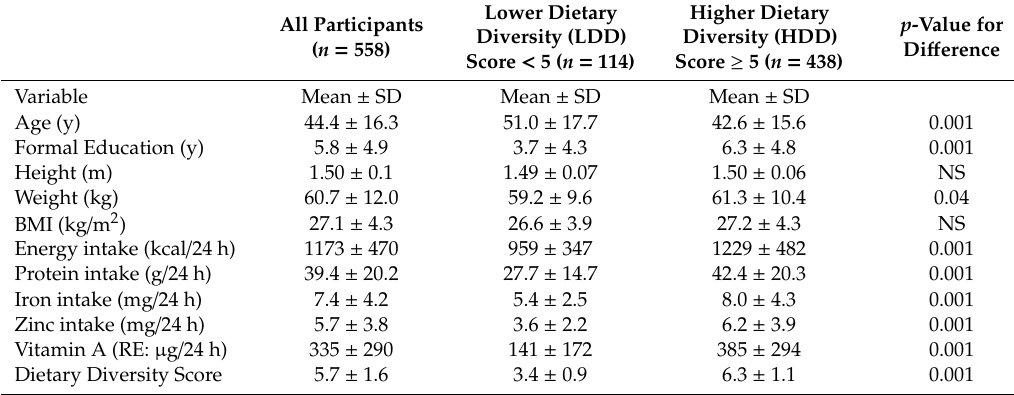
Table 1. Descriptive characteristics of all study participants and the same participants divided by those with low dietary diversity (LDD < 5 food groups) compared to women whose diets met the minimum dietary diversity (HDD ≥ 5 food groups).